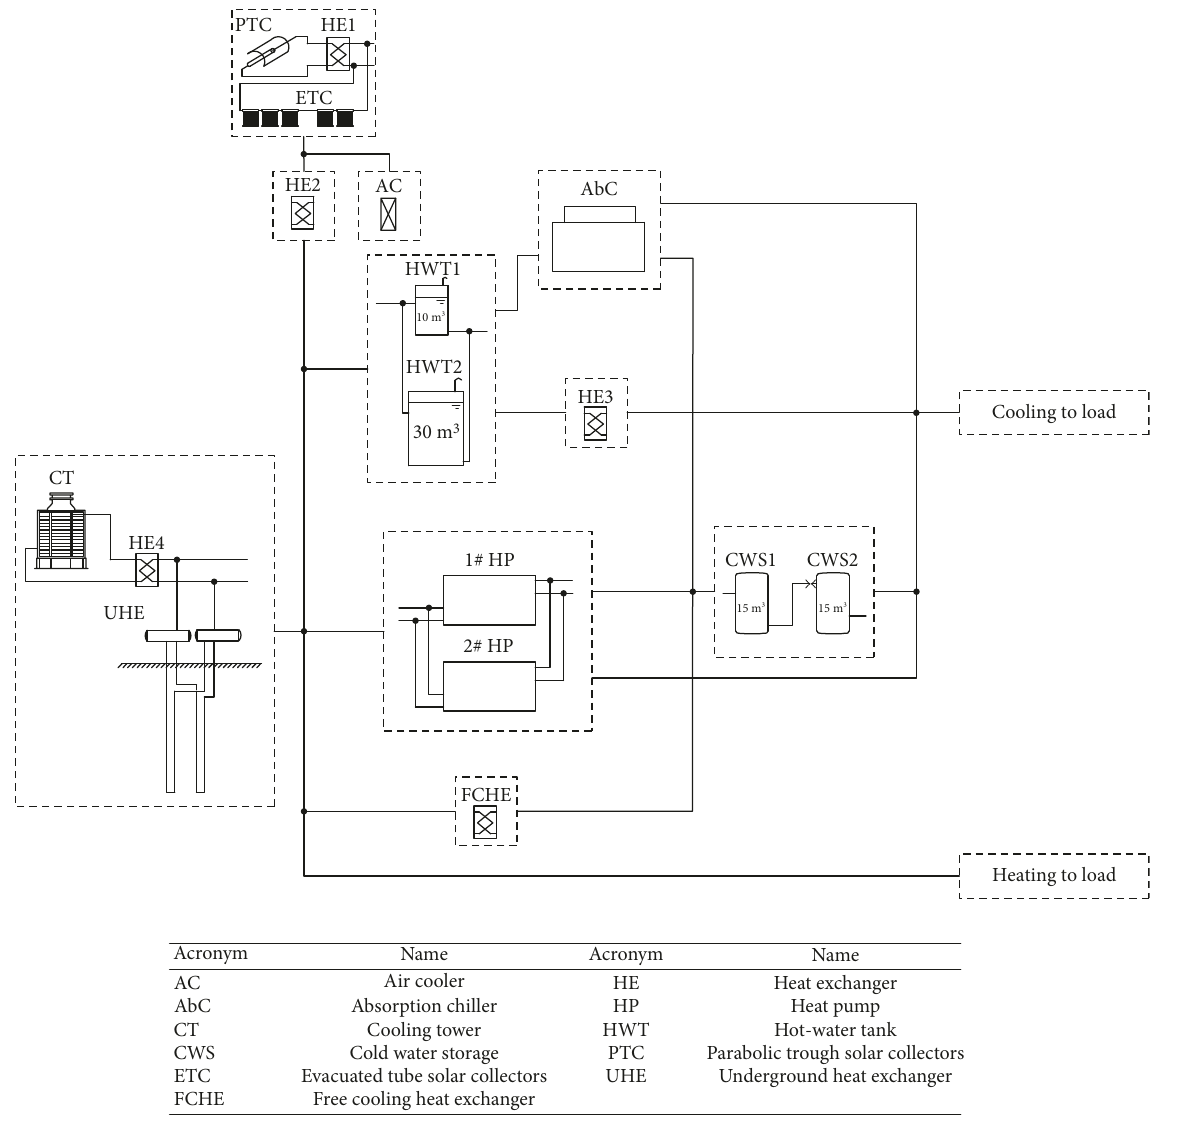
Figure 1: General concept of SHC in